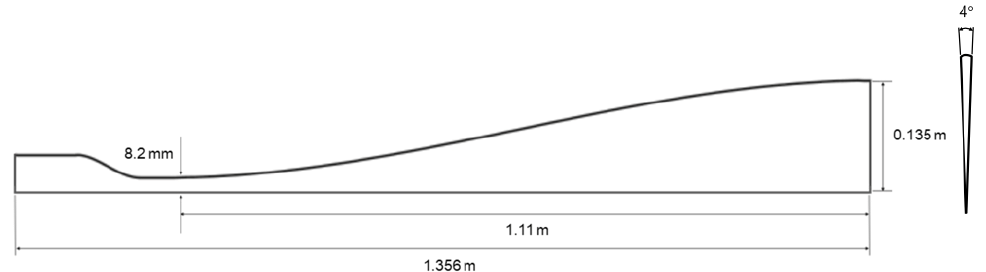
Figure 2. Computational domain of the nozzle of the T4 shock tunnel.